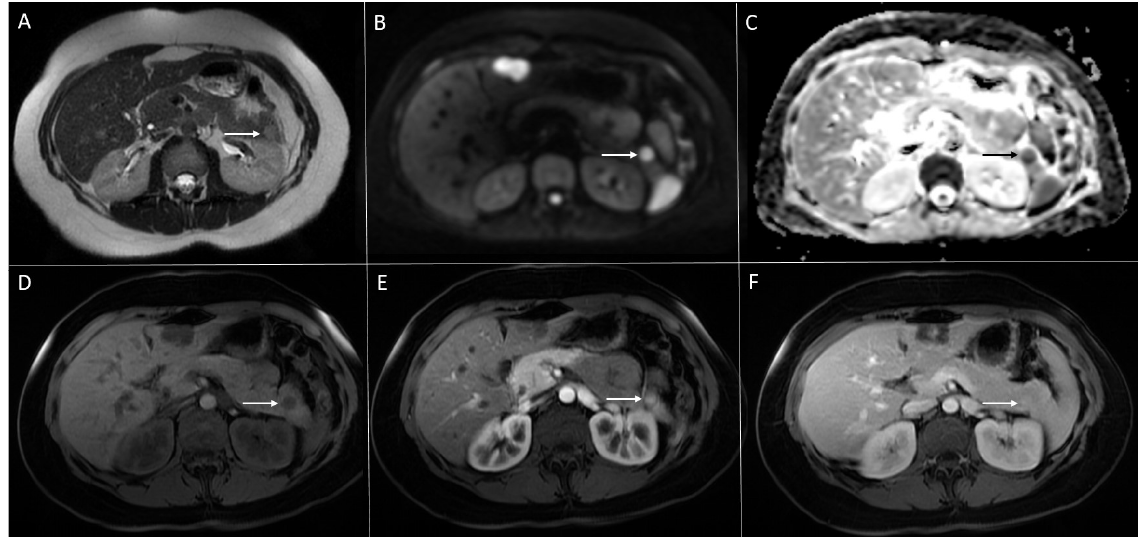
Figure 7. Intrapancreatic accessory spleen in 56-year-old women. Axial T2-weighted image ( A ) shows small slightly round hyperintense lesion ( arrow ) located in the pancreatic tail. On DWI ( B ), the lesion is hyperintense with low signal intensity on corresponding ADC map ( C ). On T1-weighted fat-suppressed image ( D ), the lesion ( arrow ) is hypointense with intense enhancement in arterial phase ( E ) remaining well-vascularized on portal-venous phase ( F